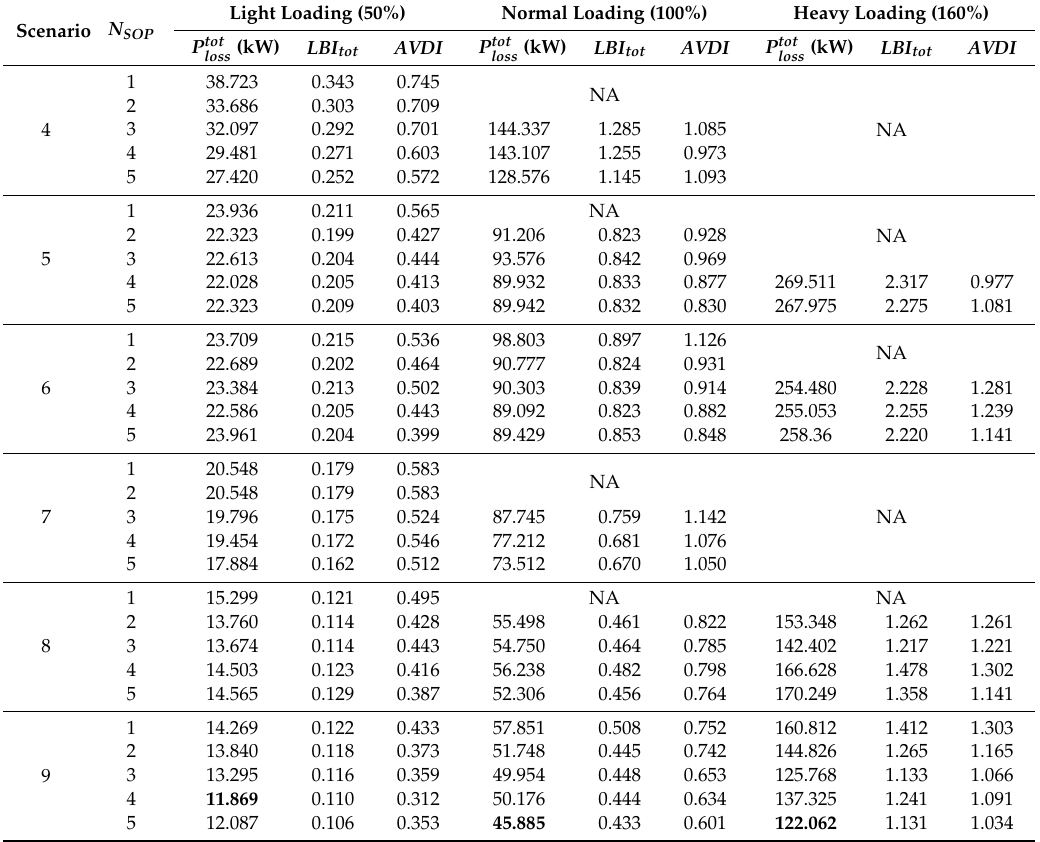
Table 3. Total Power Losses and PQ Indices for Scenarios 4 to 9 with Lossless SOPs Installed: IEEE 33-node